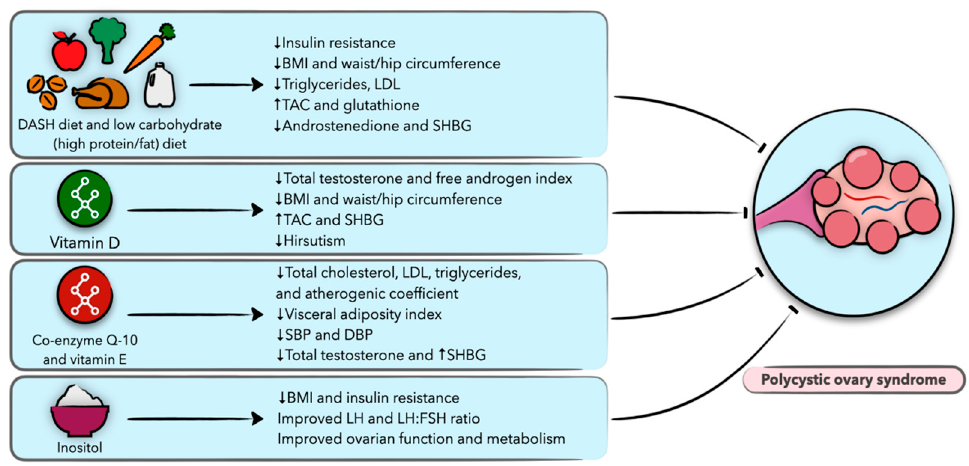
Figure 3. Schematic presentation of the role of diet and nutrition in polycystic ovary syndrome (PCOS) and the possible underlying biological mechanisms.